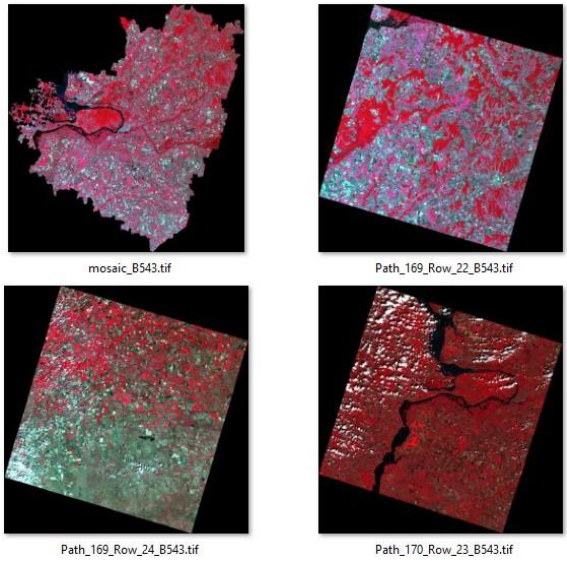
Figure 9. Construction of mosaics and composites for vegetation maps.